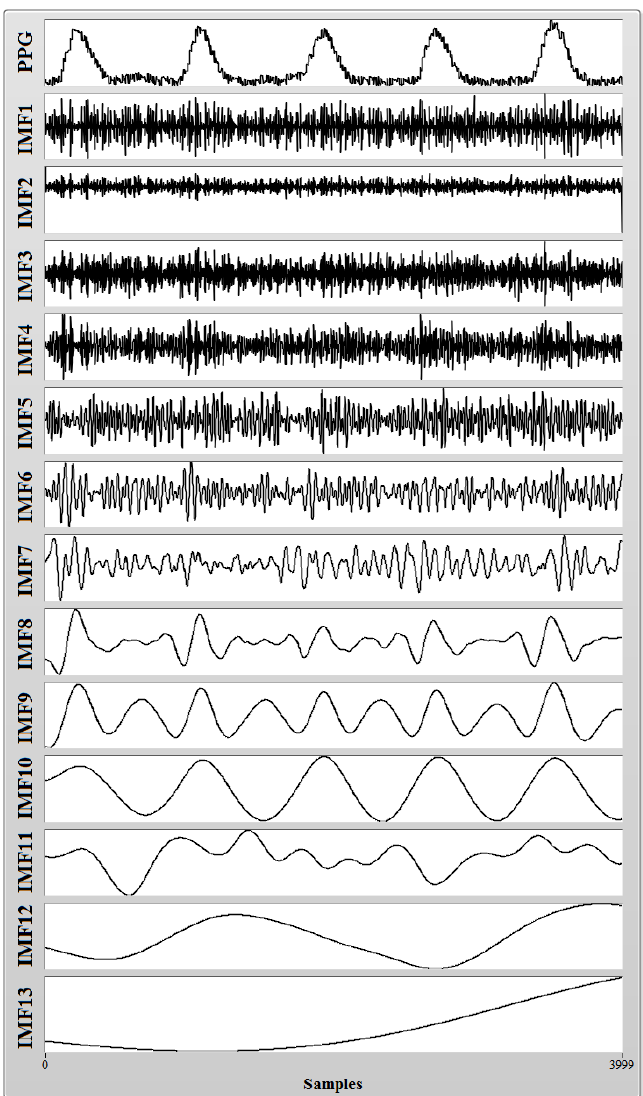
Figure 2. Intrinsic mode functions (IMFs) obtained after Complete Ensemble Empirical Mode Decomposition with Adaptive Noise (CEEMDAN) decomposition of a noisy Photoplethysmograph (PPG)